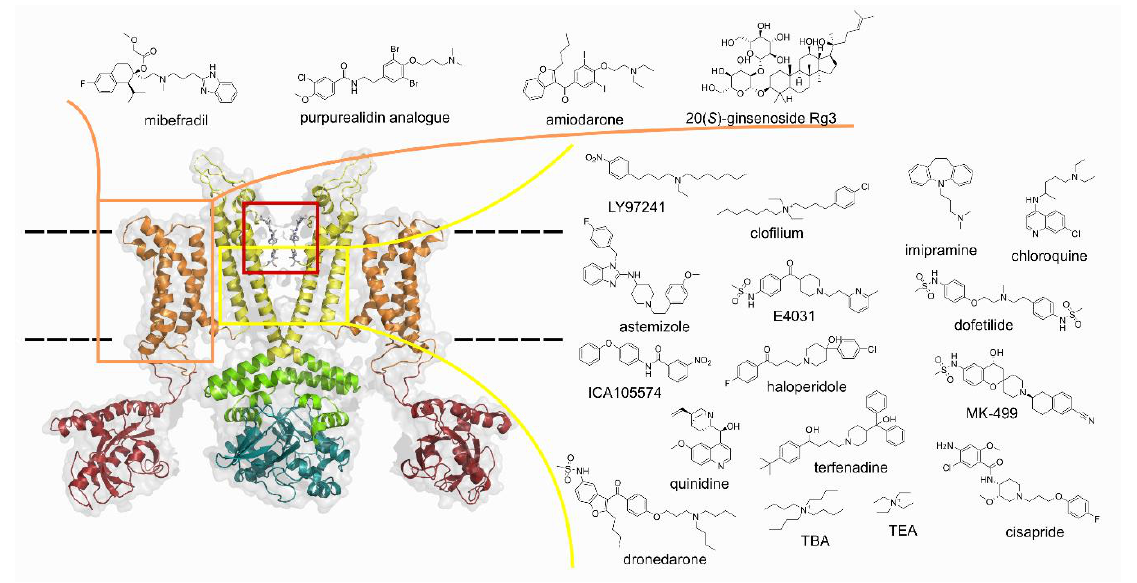
Figure 1. Opposite two subunits of K V 10.1 with voltage-sensor domain (VSD) in orange, pore domain and central cavity in yellow, selectivity filter in red box. Structures of known ligands binding to the VSD and the central cavity of the pore domain. The structure (PDB: 5k7l) in the figure represents Kv10.1 with the pore domain in the closed conformation due to calmodulin binding and VSD in the upward/conductive conformation. TBA: tetrabutylammonium: TEA: tetraethylammonium. The structure of K V 10.1 was prepared using PyMOL [21].